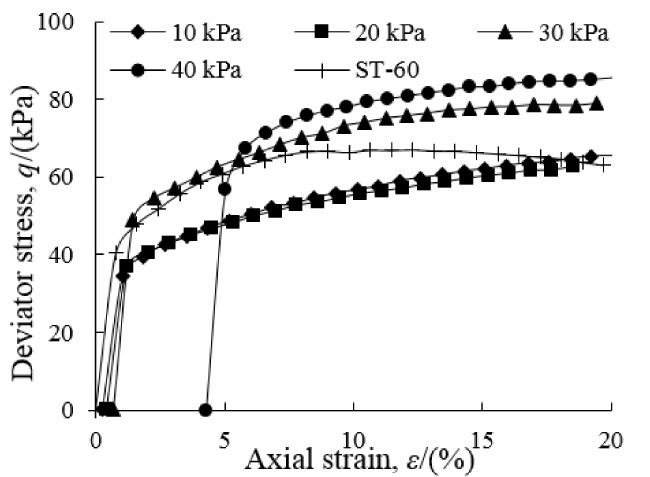
Figure 7. Relationship between axial deviator stress and axial strain of the soft soil with different cyclic stress ratio ( n = 1000, p (cid:48) 0 = 60 kPa, U r =